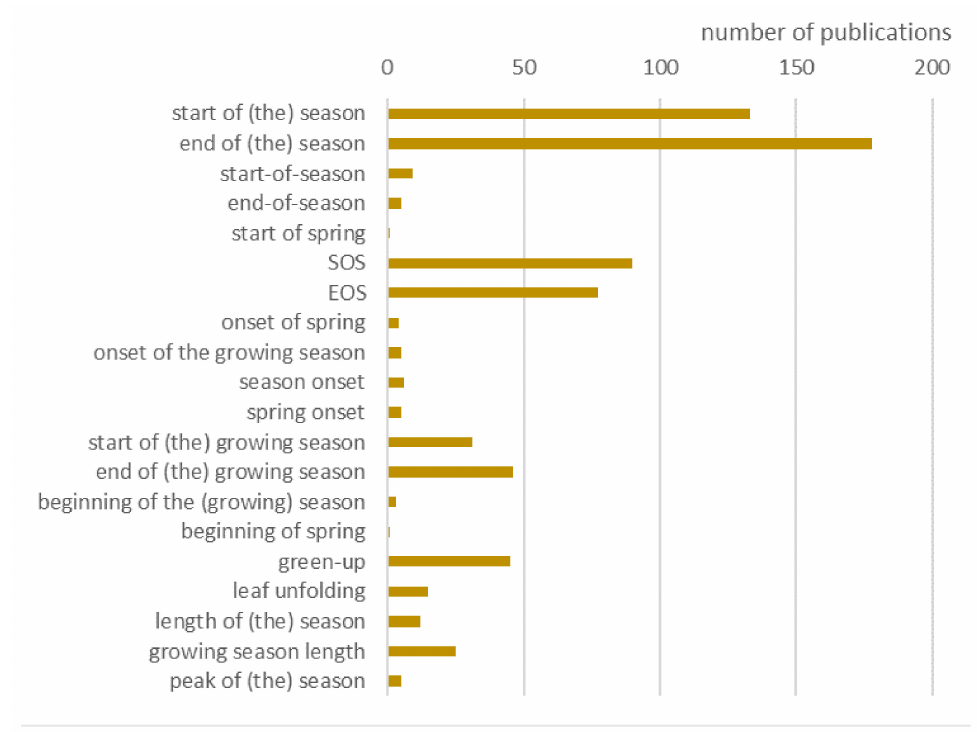
Figure 6. Frequency of phrases expressing season metrics in the analyzed publication